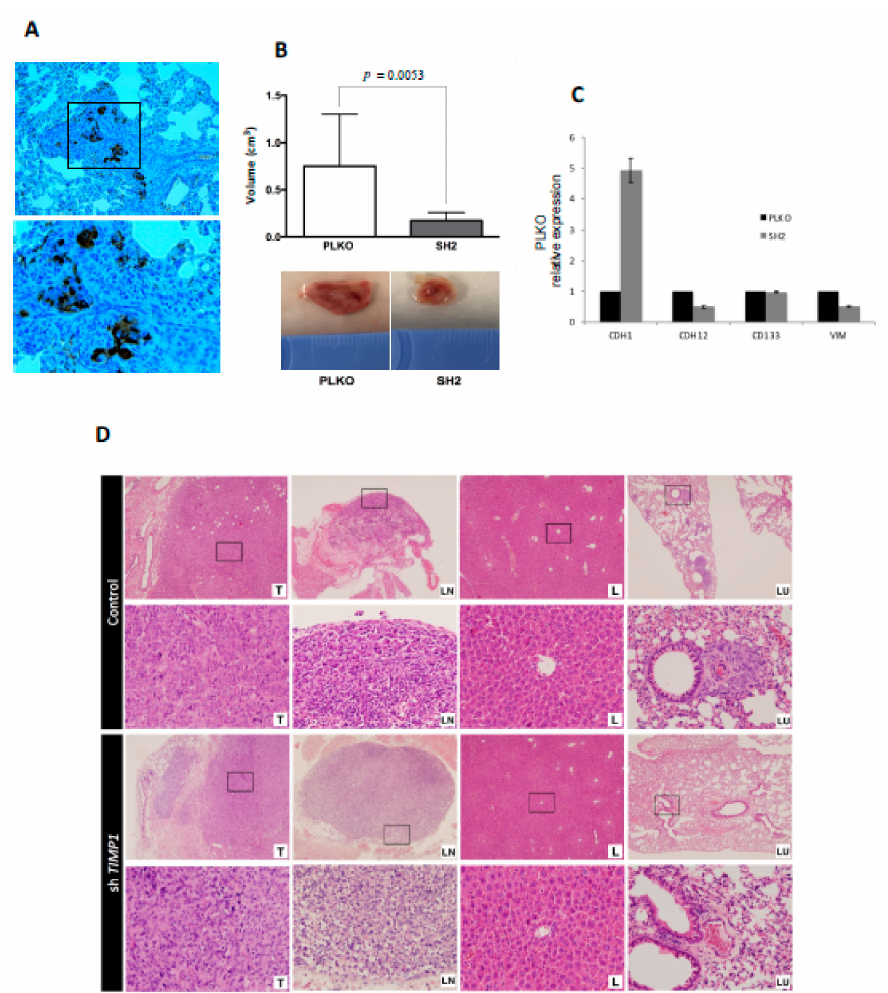
Figure 5. Impact of TIMP1 knock-down in MDA-MB-231 proliferation and dissemination in a murine orthotopic model. ( A ) CKs (EA1 / EA3) expression in the lung tissue of the control group, confirming the presence of lung metastasis. The image was taken at 20 × and respective magnification (square) at 40 × ; ( B ) Mean tumor volume in PLKO and SH2 (n replica = 3 mice / condition, n total = 9 mice / condition; two-sided Mann–Whitney U-test; p = 0.0053) after sacrifice (upper image). Representative images of tumor volume in both experimental groups (down image); ( C ) ECAD ( CDH1 ), NCAD ( CDH12 ), CD133 and VIM expression levels in primary tumors generated by PLKO and SH2 cell variants ( n = 2); ( D ) Representative images of hematoxylin-eosin staining of the di ff erent mouse tissues after the orthotopic injection of the control cell line (PLKO) and the TIMP1 silenced one (SH2). T: Primary tumor; LN: Axillary lymph node; L: Liver; LU: Lung. 4 × images and their respective magnifications (square) at 20 ×